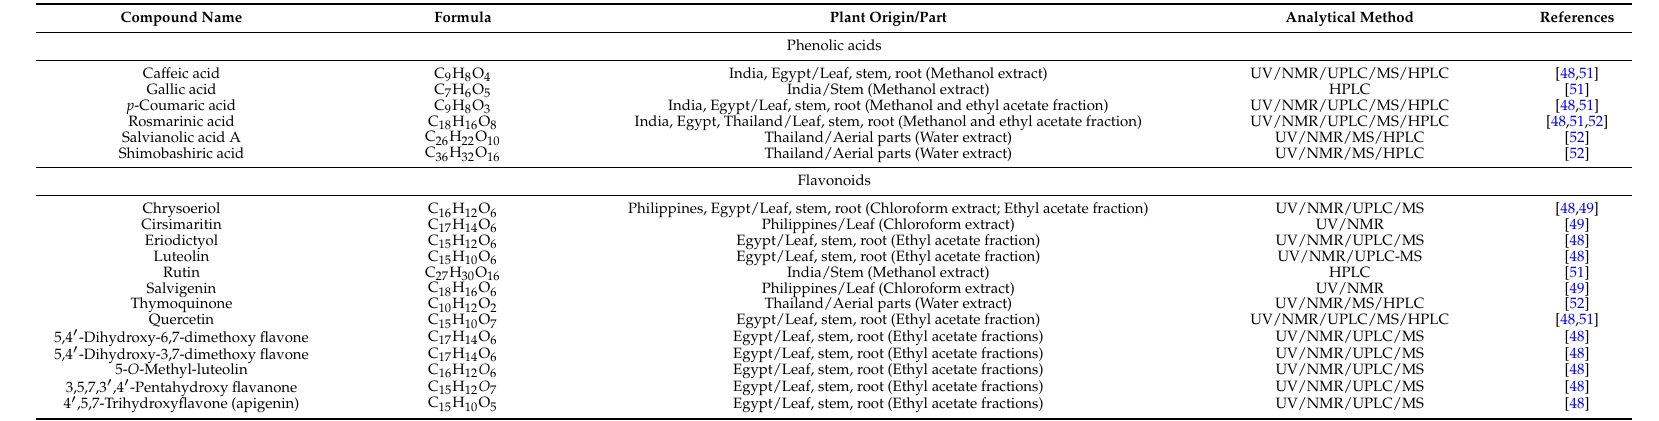
Table 3. The known non-volatile constituents of P.